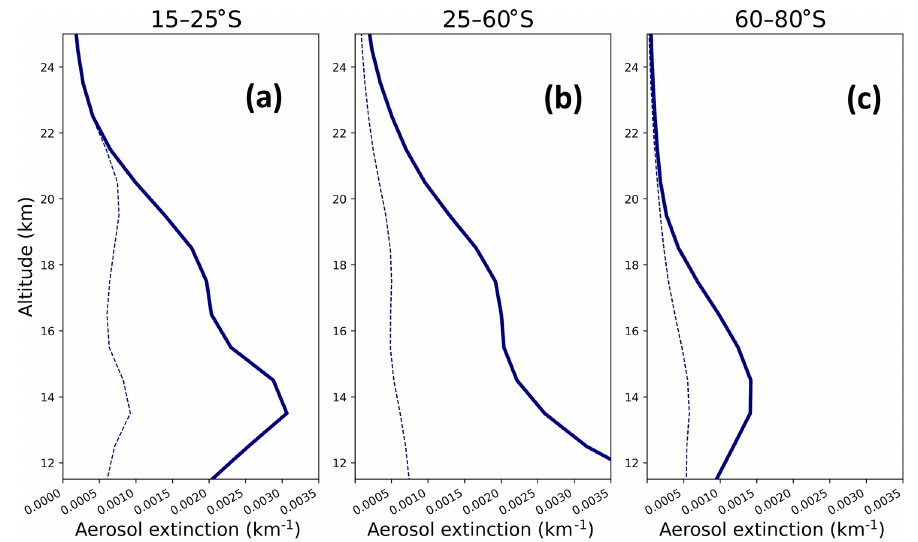
Figure 4. Monthly mean OMPS-LP aerosol extinction coefficient profiles at 675nm, for the months of February 2020 (perturbed profiles, solid lines) and February 2019 (background profiles, dashed lines), in the latitude interval 15–25 ◦ S (a) , 25–60 ◦ S (b) and 60–80 ◦ S (c)